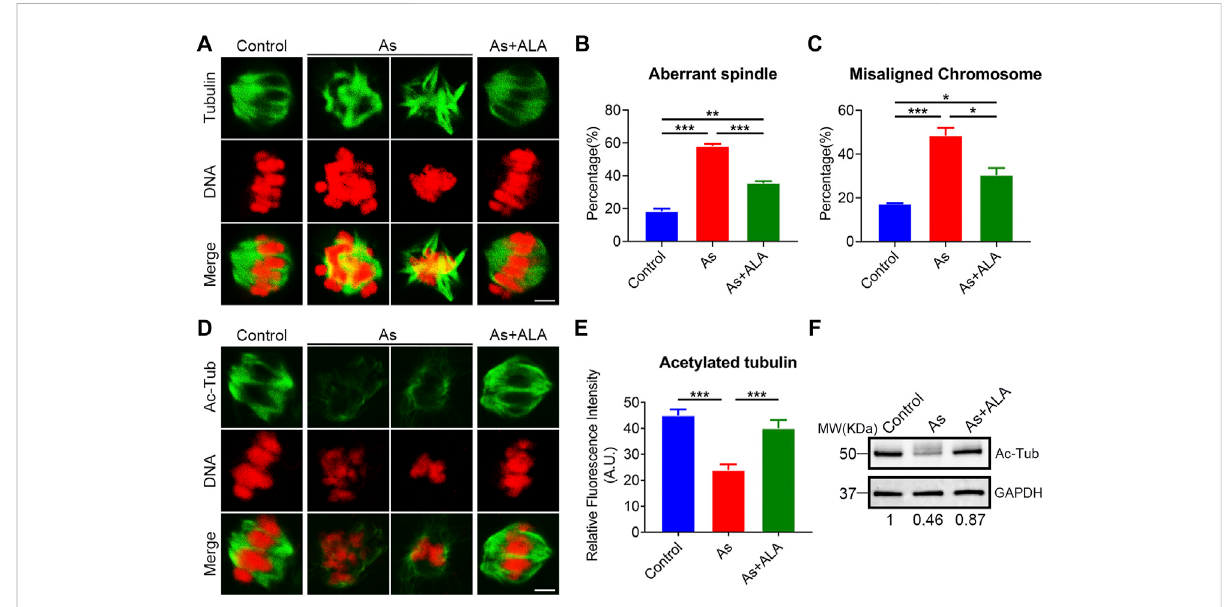
FIGURE 2 Effect of ALA supplementation on spindle assembly, chromosome alignment and microtubule stability in arsenite-exposed oocytes. (A) Representative images of spindle morphologies and chromosome alignment in control, arsenite-exposed and ALA-supplemented groups. MI oocytes were immunostained with anti- α -tubulin-FITC antibody and counterstained with propidium iodide (PI). Scale bar, 3 µm. (B) The rate of aberrant spindle were calculated in control, arsenite-exposed and ALA-supplemented groups. (C) The rate of misaligned chromosomes were calculated in control, arsenite-exposed and ALA-supplemented groups. (D) Representative images of acetylated α -tubulin in control, arsenite- exposed and ALA-supplemented groups. MI oocytes were immunostained with anti-acetyl- α -tubulin antibody and counterstained with propidiumiodide (PI). Scale bar, 3 µm. (E) The fl uorescence intensity of acetylated α -tubulin was quanti fi ed in control, arsenite-exposed and ALA- supplementedgroups. (F) Theacetylationlevelof α